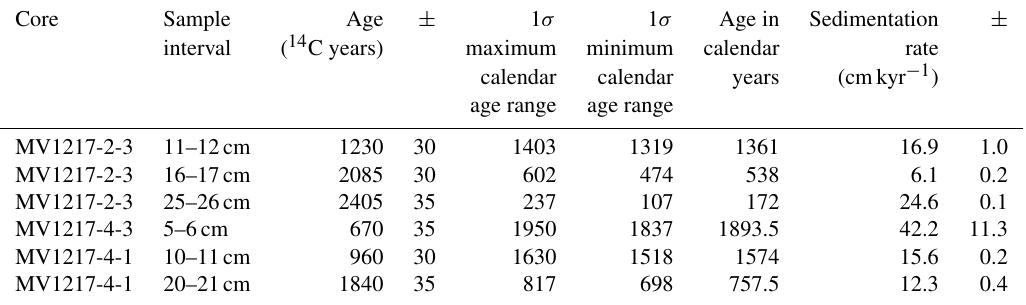
Table 2. Radiocarbon ages of mixed planktonic foraminifera from MV1217-2-3 (528m water depth), MV1217-4-3 (1175m water depth), and MV1217-4-1 (1175m water depth). Core Sample Age ± 1 σ 1 σ Age in Sedimentation ± interval ( 14 C years) maximum minimum calendar rate calendar calendar years (cmkyr − 1 ) age range age range MV1217-2-3 11–12cm 1230 30 1403 1319 1361 MV1217-2-3 25–26cm 2405 35 237 107 172 670